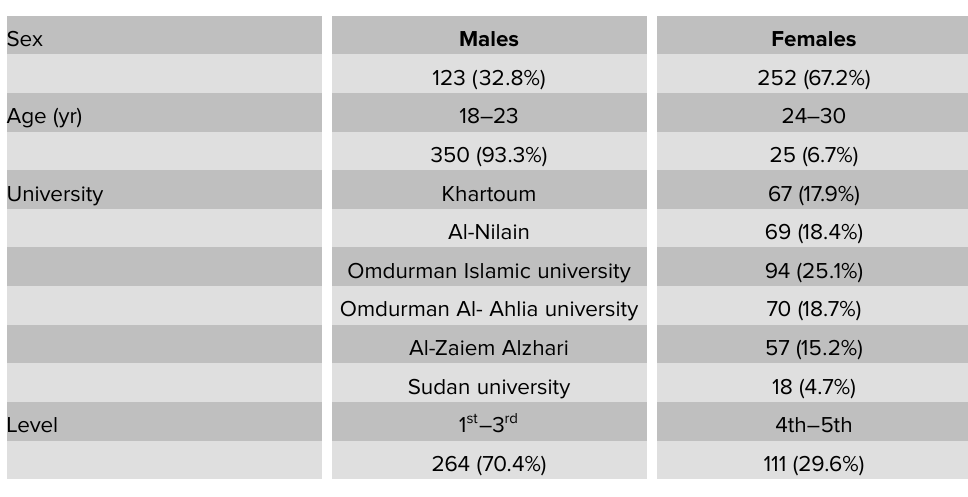
TABLE 1: Sociodemographic